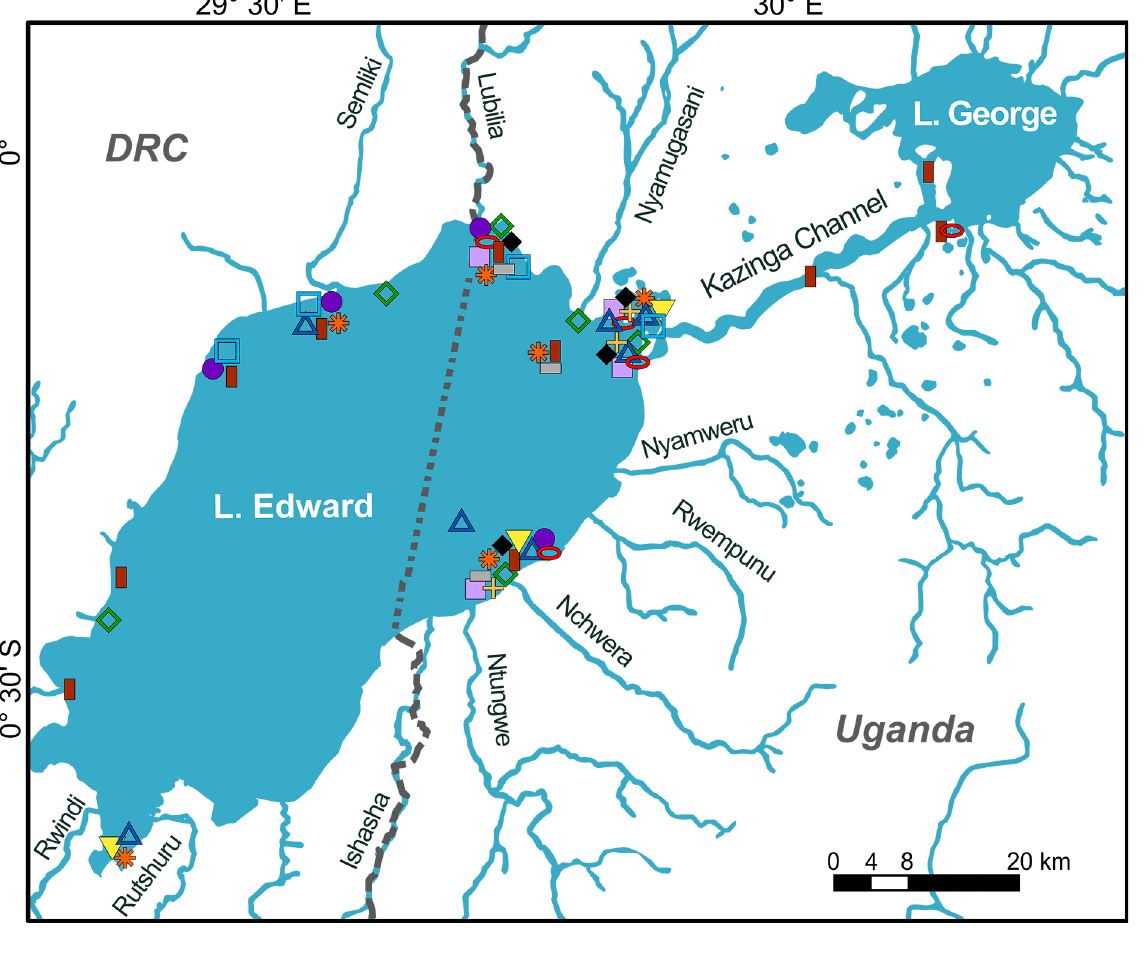
Fig. 1. The Lake Edward system, consisting of Lakes Edward and George that are connected through the Kazinga Channel. The catch localities of all examined specimens are indicated: Haplochromis sp. ‘latifrons’ ( ), H . mentatus Regan, 1925 ( ), H . sp. ‘rex’ ( ), H . sp. ‘simba’ (▼▼), H . sp. ‘glaucus’ (■), H . sp. ‘aquila’ (■■), H . sp. ‘kimondo’ (●●), H . sp. ‘falcatus’ ( ), H . sp. ‘curvidens’ ( ), H . sp. ‘pardus’ ( ), H . sp. ‘quasimodo’ ( ▲ ), and H . squamipinnis Regan, 1921 ( ██ ). The type localities of H . mentatus and H . squamipinnis are not shown as the exact locations are